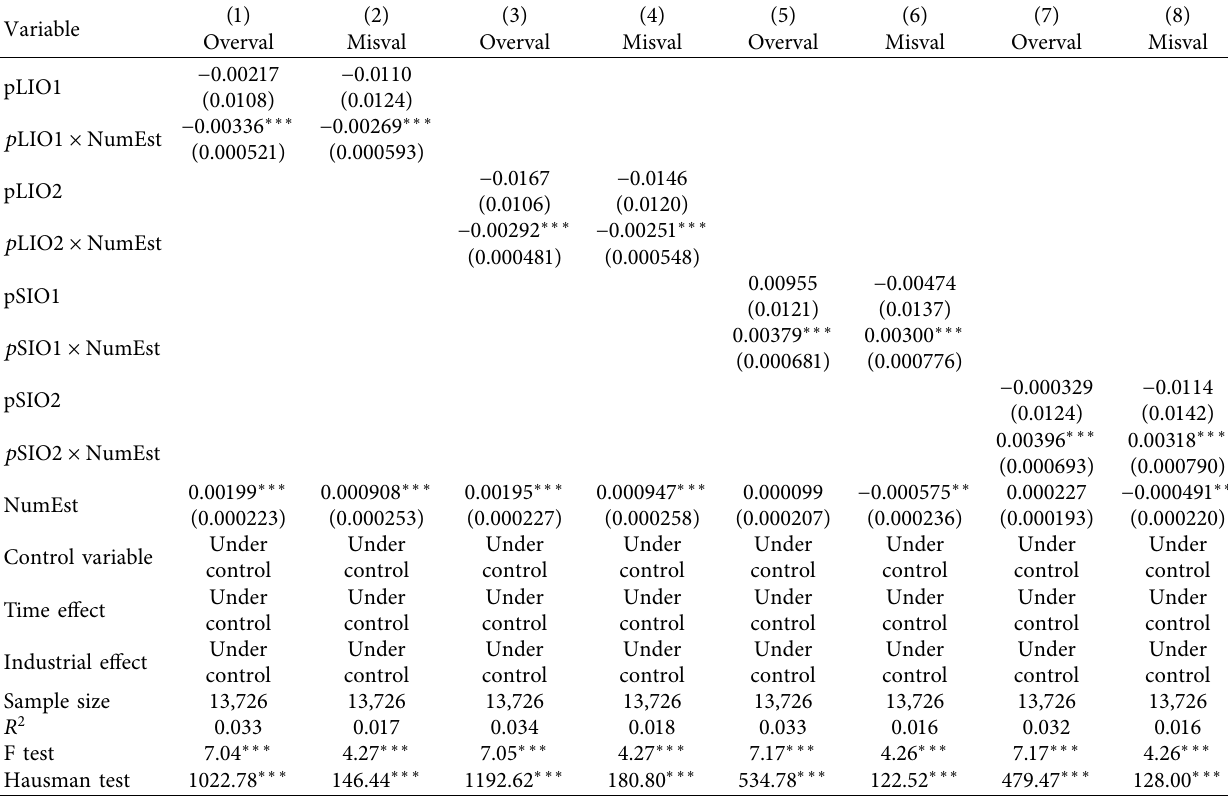
Table 6: The role of long-term and short-term institutional investors in stock mispricing under the attention of analysts.